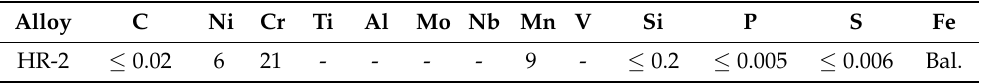
Table 1. Chemical composition of hydrogen-resistant steel (mass fraction,